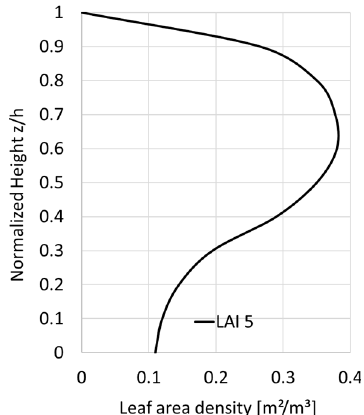
Figure 1. Distribution of leaf area density (LAD).